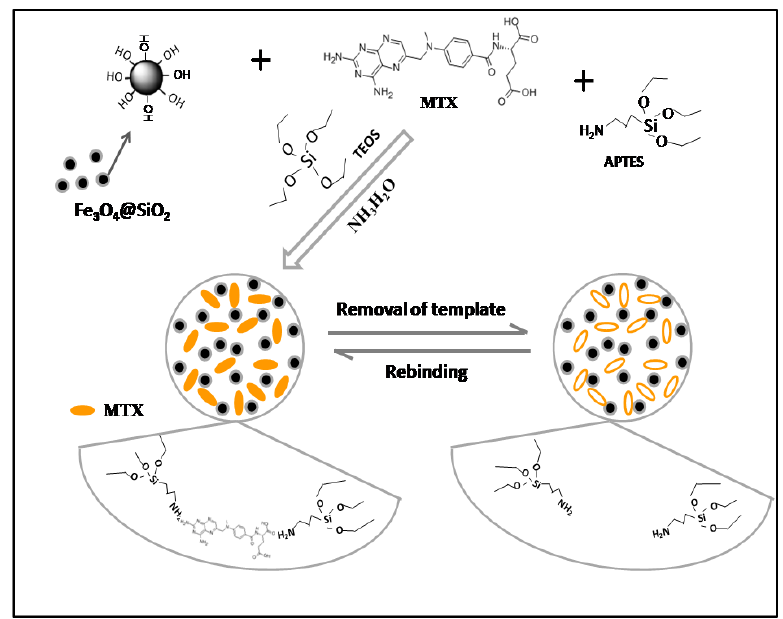
Figure 1. Preparation of MMIPs via the sol–gel process . Table 2. The influence of the ratio of the template, monomer, and crosslinker on the adsorption capacity of the polymers.